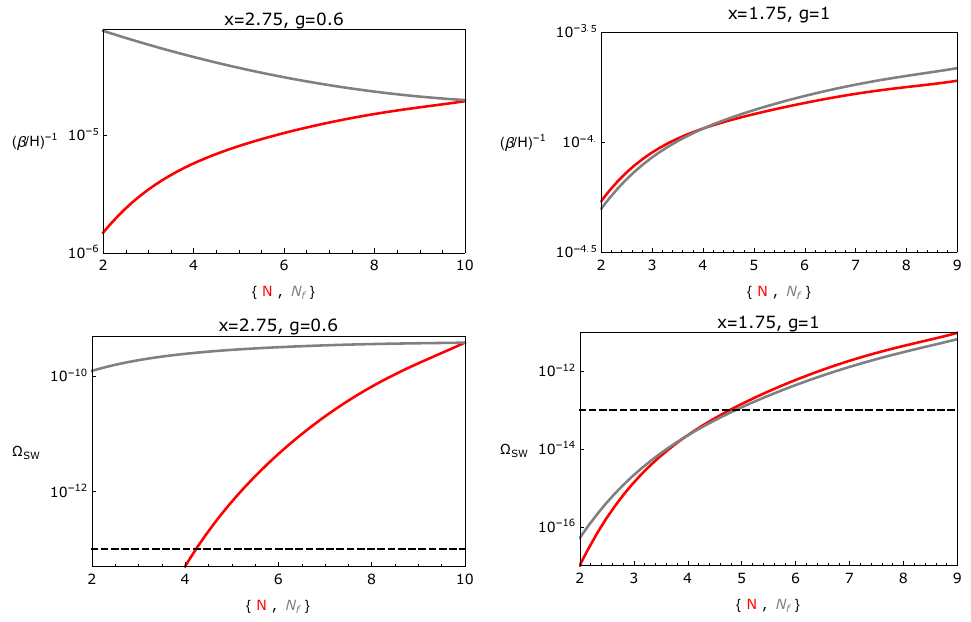
Figure 5 . Thermal parameters from the PT described by Eqs (2.5) (left) and (2.7) (right). For the non-renormalizable potentials we take (cid:11) = 0 : 8. In the cases where we vary N F we set N = 10(4), whereas in the cases where we vary N we set N F = 10(4) for the renormalizable and non-renormalizable potentials respectively. The black dashed line shows LISA visibility for a power spectrum integrated over frequency taken from